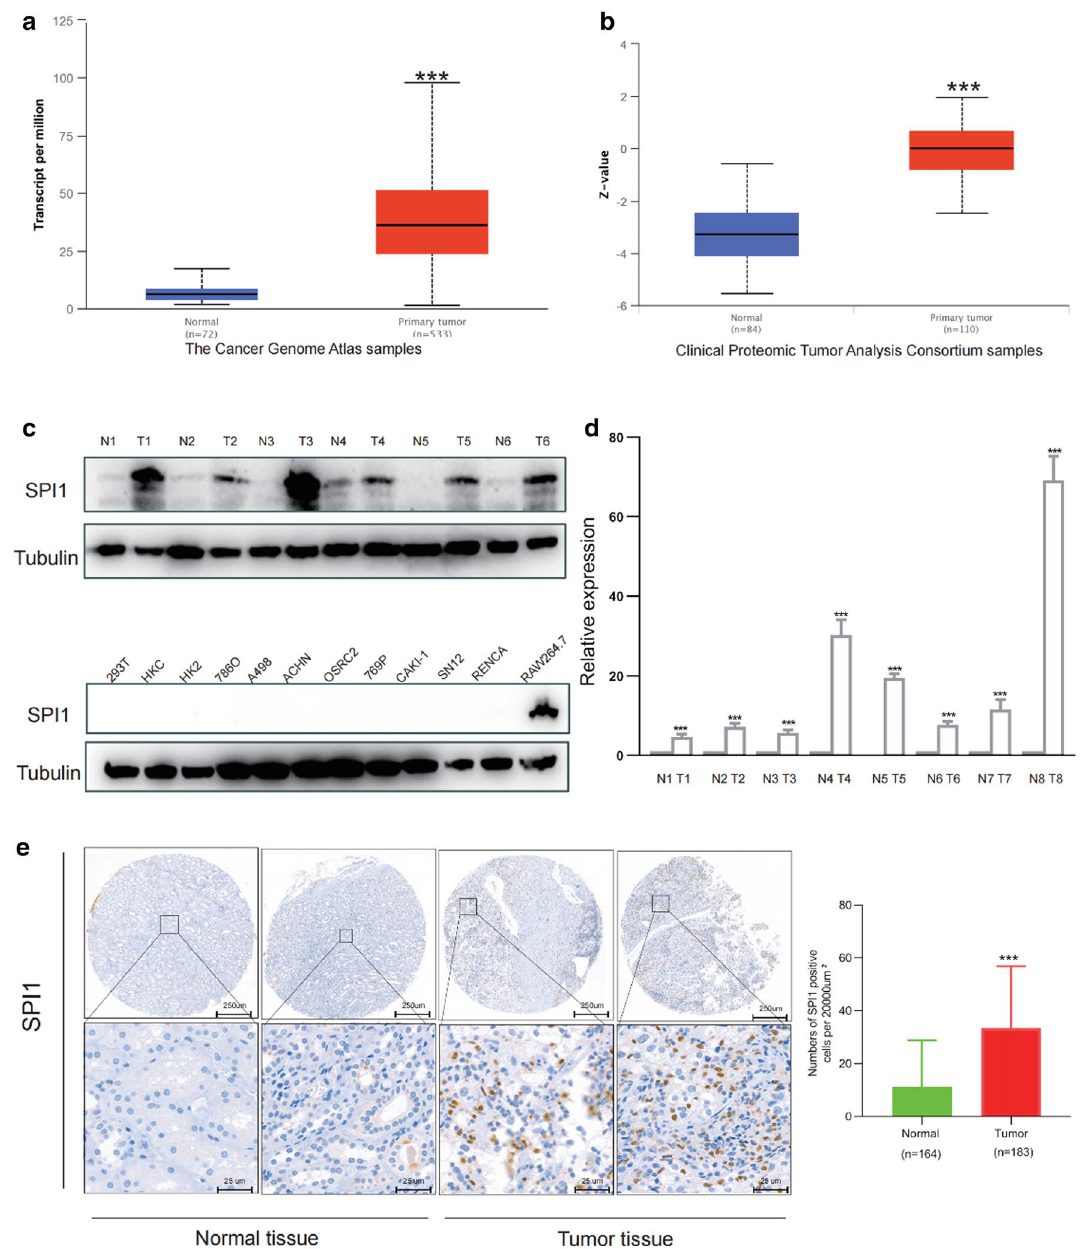
Fig. 1 SPI1 expression in ccRCC. a , b SPI1 protein and mRNA expression levels were elevated in ccRCC bulk tissues compared to normal bulk tissues in the UALCAN database. c SPI1protein expression levels in six pairs ccRCC tumor bulk tissues and adjacent normal bulk tissues as well as ccRCC cell lines. d SPI1 mRNA expression levels in eight ccRCC tumor bulk tissues and adjacent normal bulk tissues ( e ) SPI1 protein expression levels was elevated in ccRCC stroma compared to normal stroma in our cohort. ccRCC, clear cell renal cell carcinoma; *, p < 0.05; **, p < 0.01; ***, p <